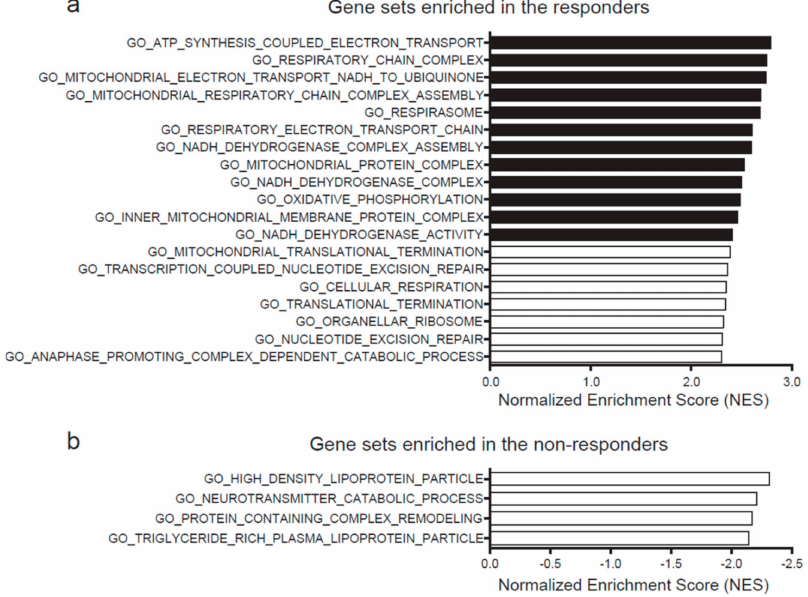
Figure 3. Genes sets enriched in the responders ( a ) and the non-responders ( b ). Gene sets with fami- lywise error rate (FWER) p -value < 0.05 are indicated in descending order of normalized enrichment score (NES) of